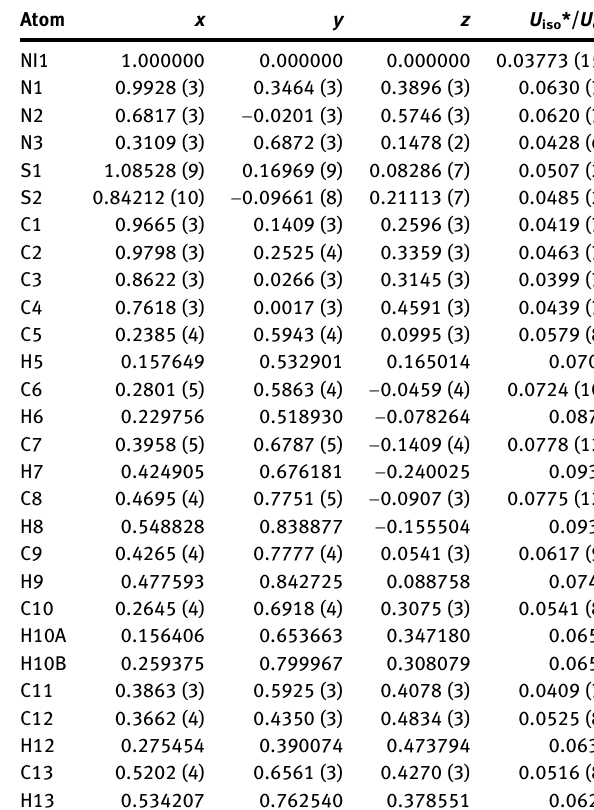
Table  : Fractional atomic coordinates and isotropic or equivalent isotropic displacement parameters (Å 